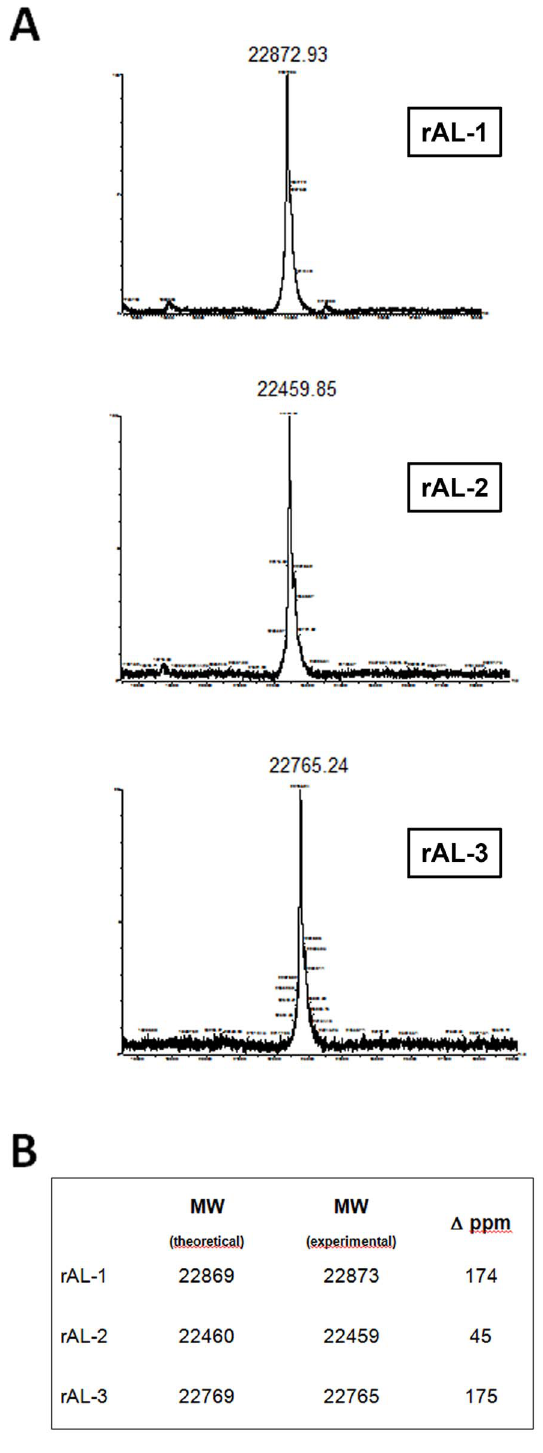
Figure 6. Intact mass determination of purified rLC by MALDI- TOF mass spectrometry. Panel A shows the peaks corresponding to the single charged ions. Panel B shows the calculated (including the presence of an N-terminal methionine) and the observed intact masses of each LC. The error (ppm) from the calculated mass is reported. The results are consistent with the predicted molecular